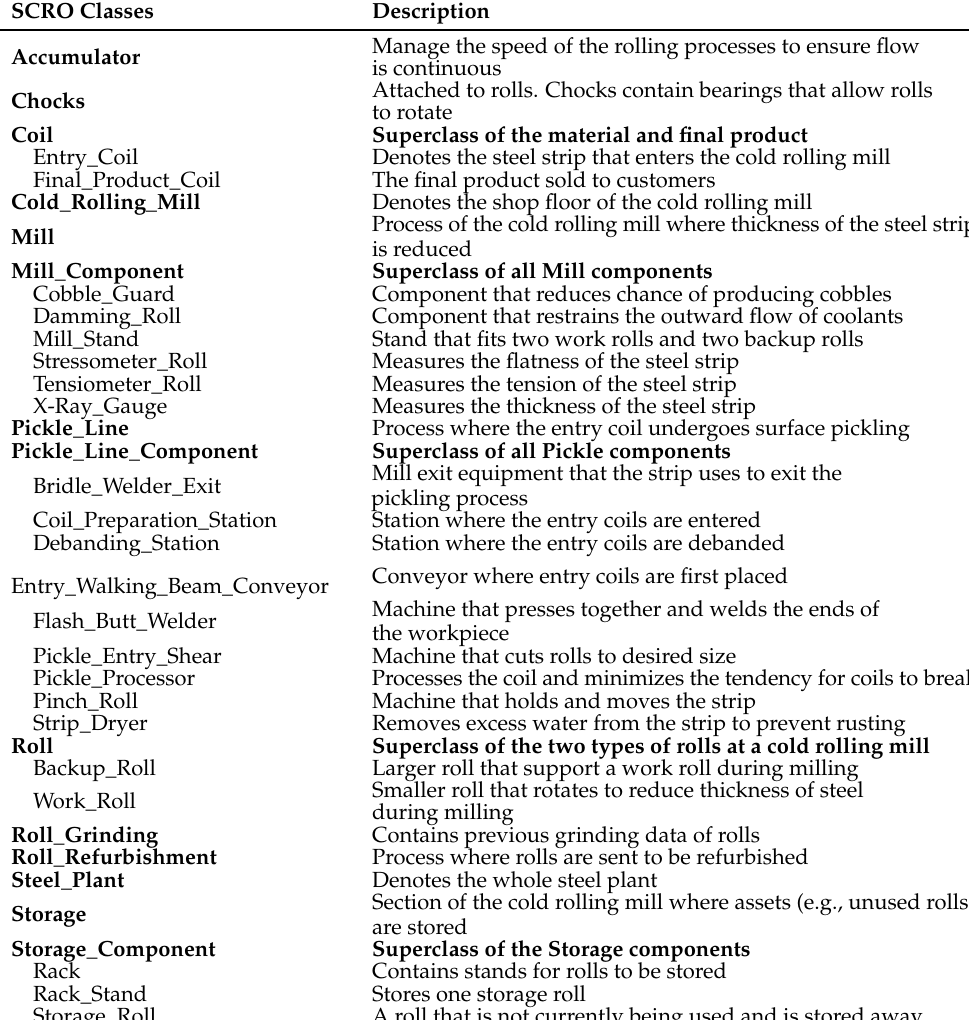
Table 1. Description of SCRO